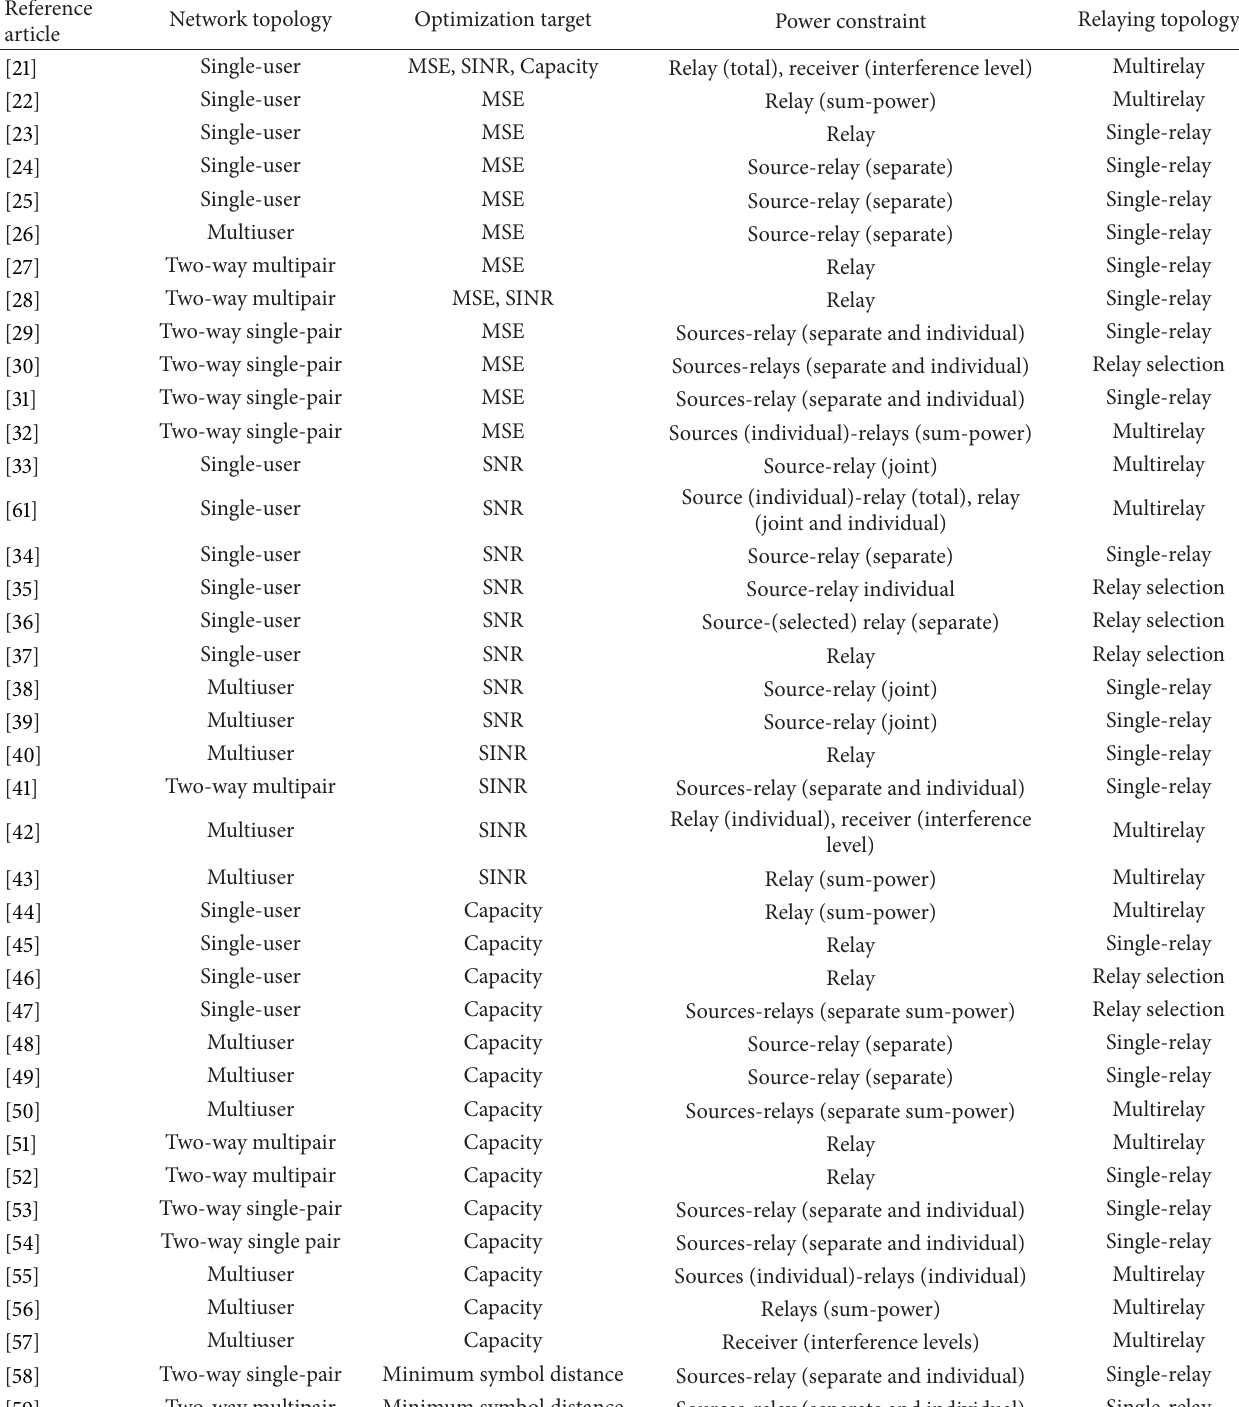
Table 2: Classification of articles based on network topology, the optimization target with the corresponding power constraint, and the relaying topology